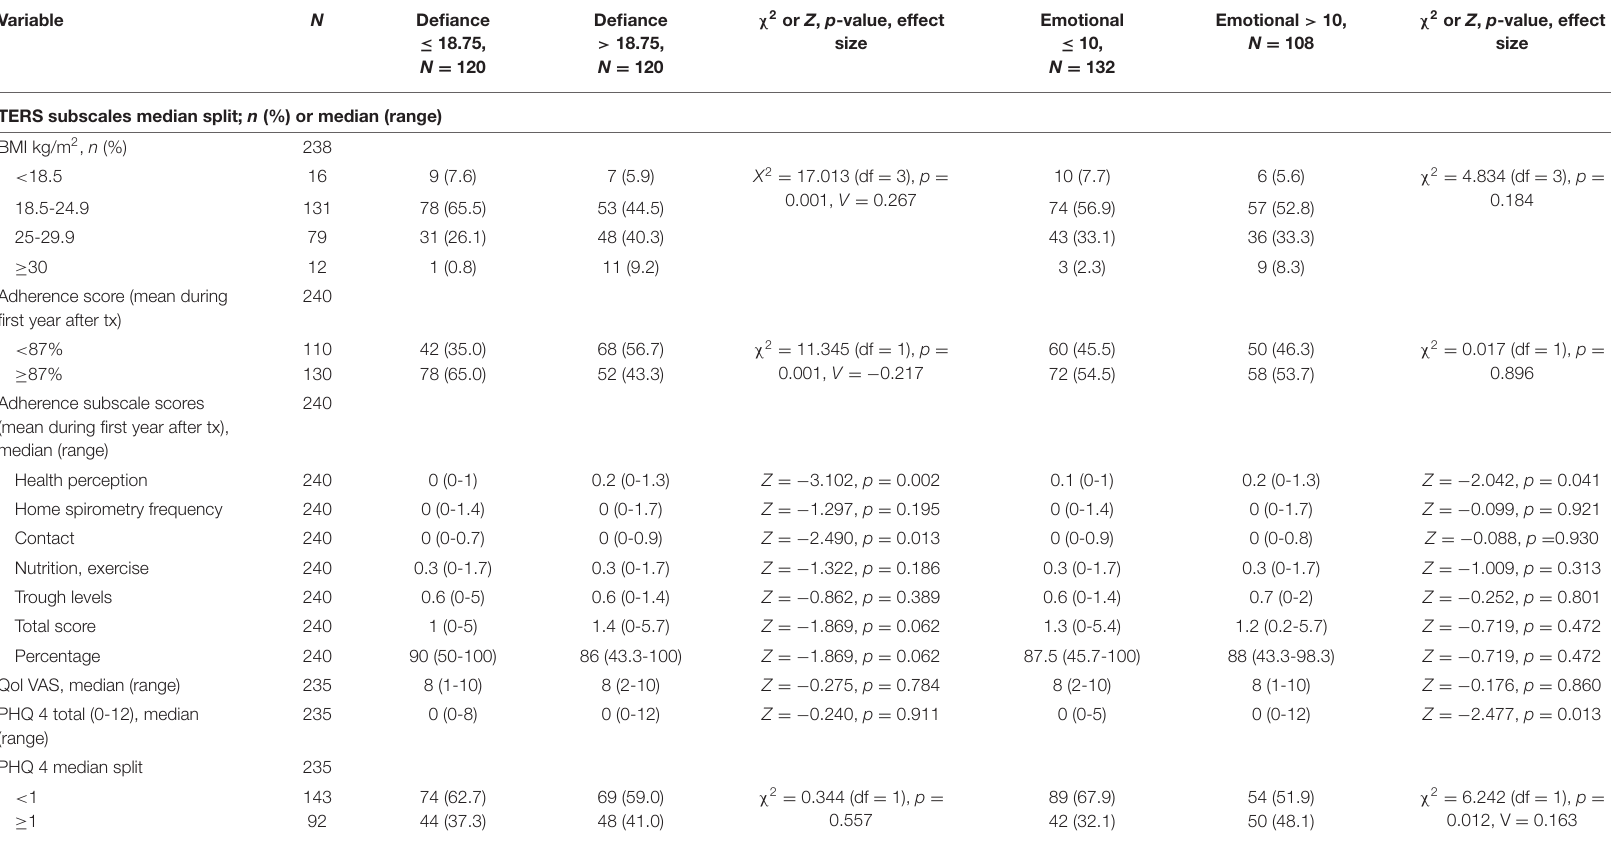
χ 2 or Z , p -value, effect Emotional > 10, Emotional ≤ 10, N = 108 size N = 132